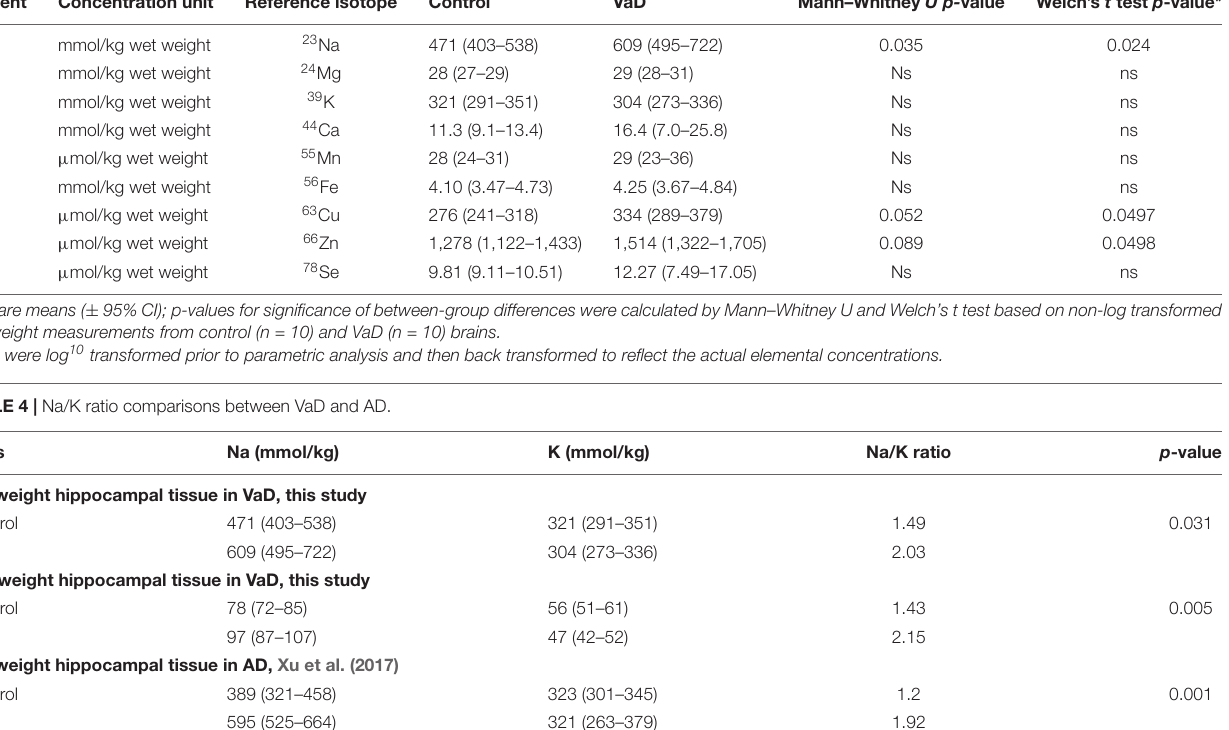
TABLE 3 | Dry-weight metal concentrations in hippocampus of VaD and control brains. Element